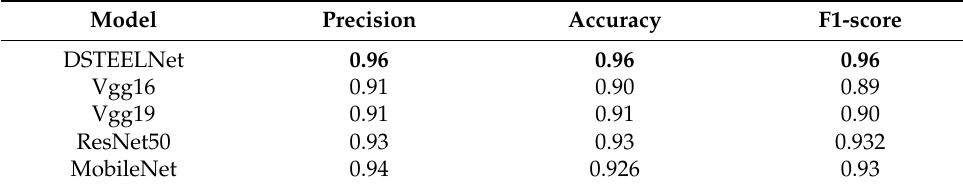
Figure 10. Confusion matrices for DSTEELNet , and ResNet50 on test GNEU dataset. Table 5. Weighted average results on Severstal